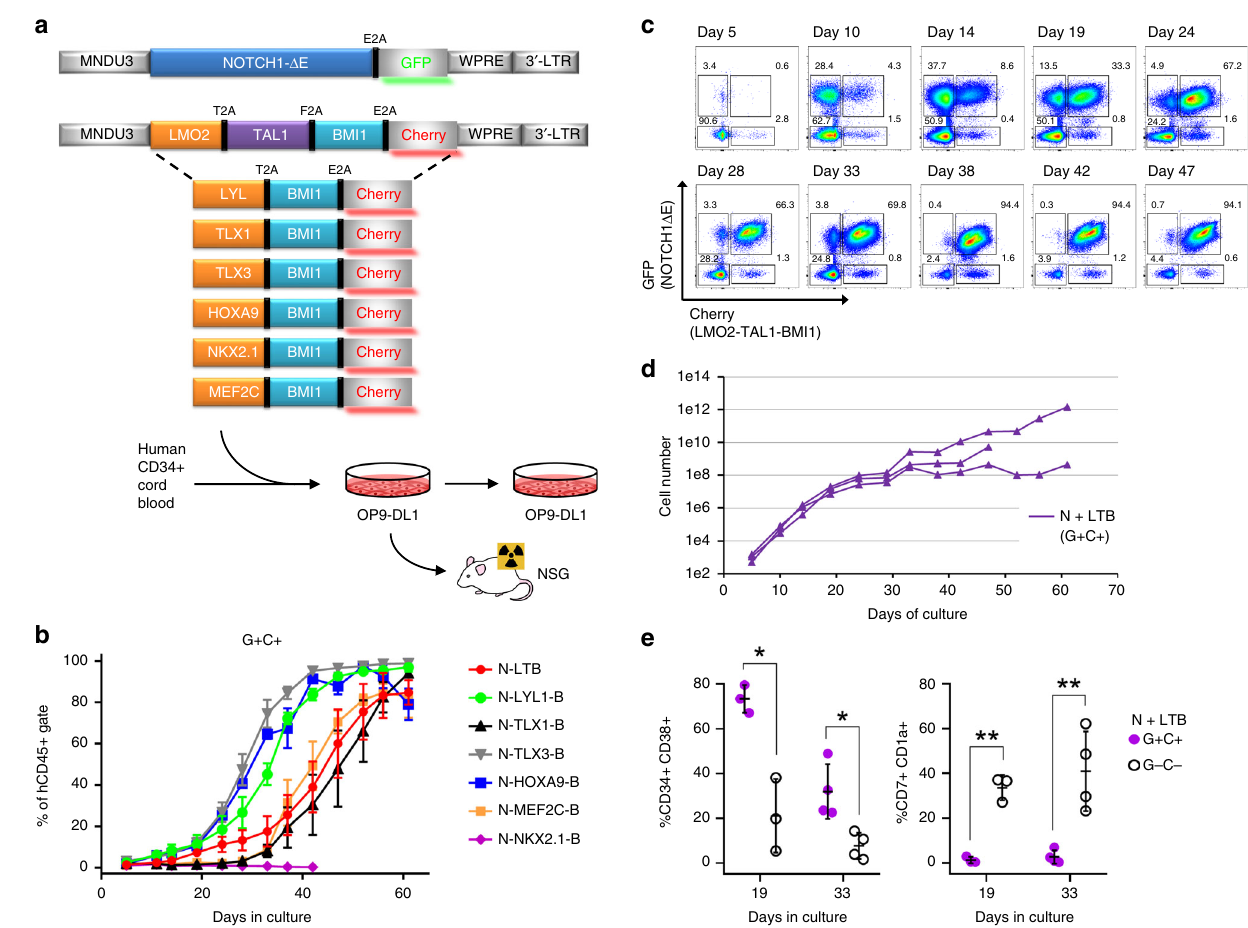
Fig. 1 NOTCH1 combined with other T-ALL oncogenes drives expansion of CB cells in vitro. a Experimental schema. Human CD34 + cord blood cells were transduced with GFP and Cherry lentiviral constructs, then plated on OP9-DL1 stromal feeders for varying periods of time prior to transplantation into immunode fi cient NSG mice. b Flow cytometric tracking of doubly transduced (GFP + Cherry + , or G + C + ) CB cells at each serial passage onto fresh OP9- DL1 feeders every 4 – 5 days. CB cells were transduced with lentiviral particles on days 0 and 5 only. Mean values ± range for duplicate experiments are plotted. c Flow cytometric tracking of NOTCH1 Δ E-GFP, LTB-Cherry-transduced CB cells cultured as in ( b ). Gated live, hCD45 + events are depicted. Data are representative of multiple replicates. d Absolute growth of NOTCH1 Δ E-GFP, LTB-Cherry doubly transduced cells (G + C + ). Total cell number is extrapolated based on fold-increase in cell yield at each passage. Growth curves from three independent experimental replicates are shown. e Flow cytometric immunophenotyping of NOTCH1 Δ E-GFP, LTB-Cherry doubly (G + C + ) and nontransduced (G − C − ) CB cell populations from days 19 and 33. Each plotted datapoint represents a separate culture. Mean± SD values are plotted. * p < 0.05 ; **p < 0.01 (two-tailed t test with Holm − Sidak correction